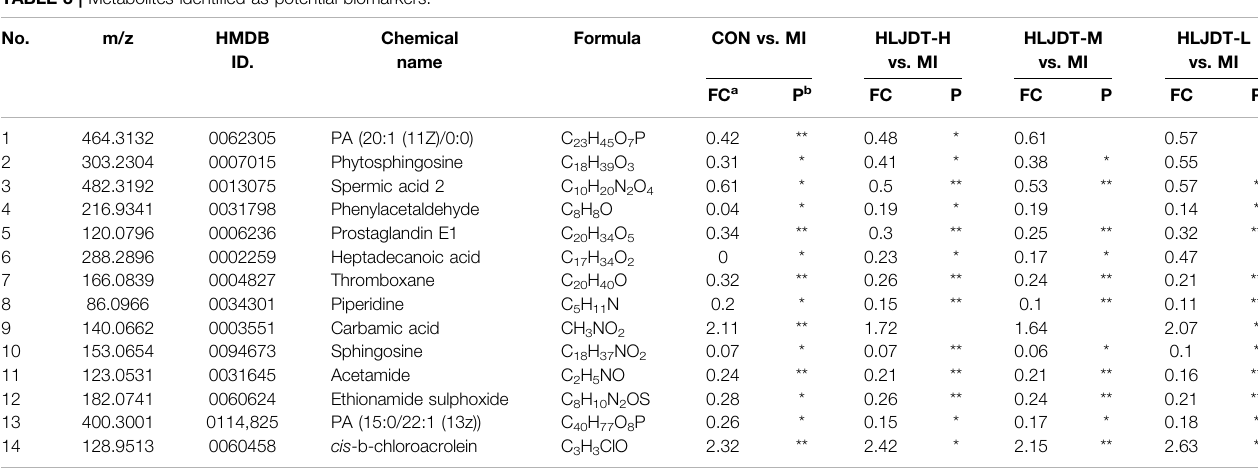
Frontiers in Pharmacology |